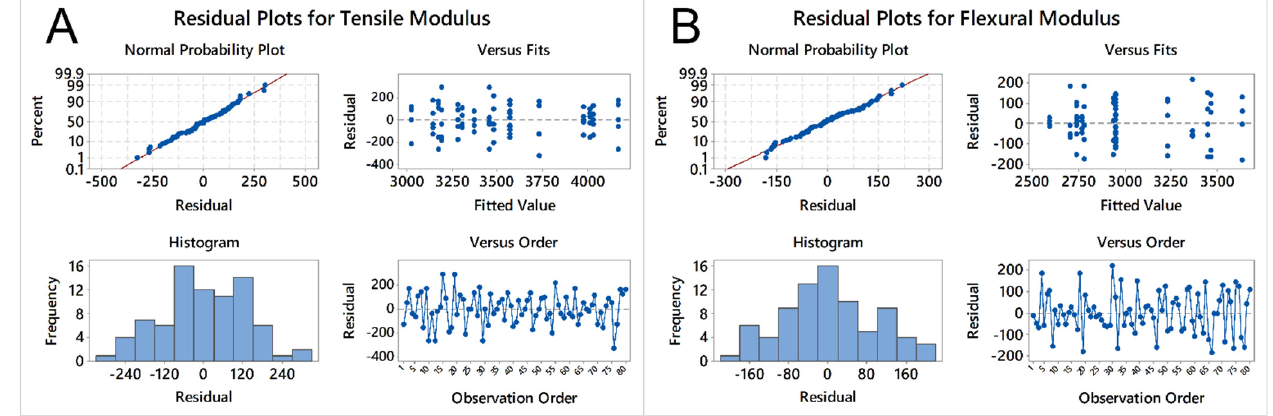
Figure 2. Residual plots for ( A ) tensile and ( B ) flexural modulus.